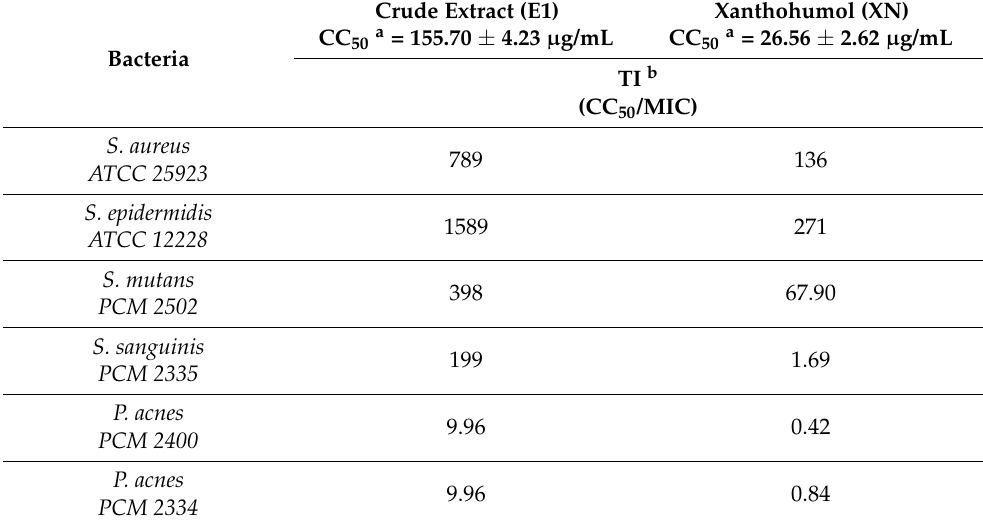
Table 6. Cytotoxicity and therapeutic index of compounds from Marynka hop